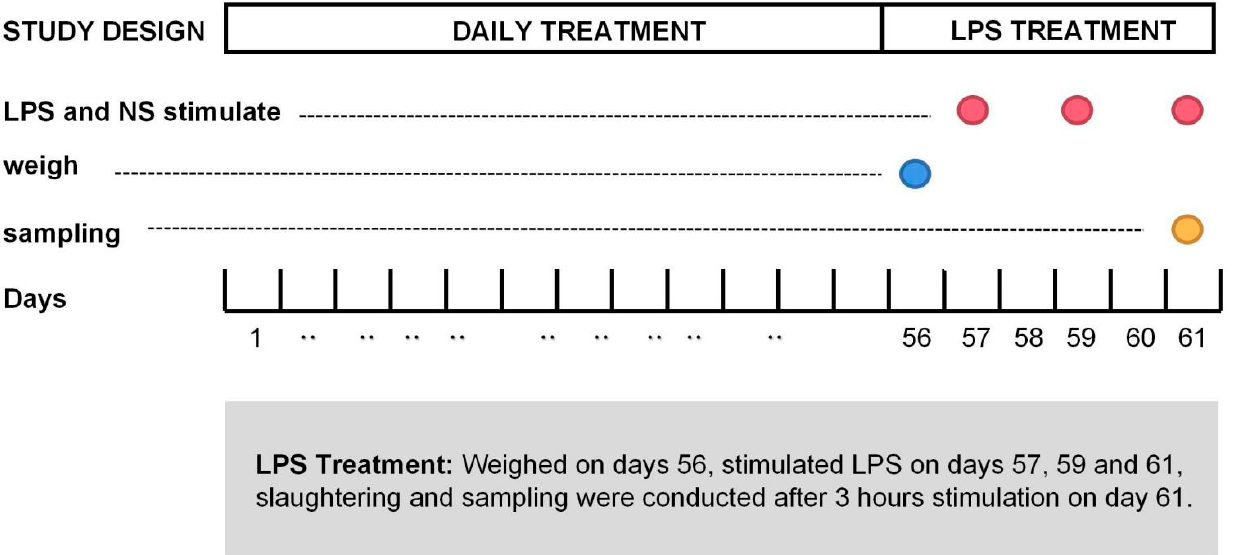
Figure 6. Design of LPS treatment. The blue circle represents the date of weighting, red circles represent the date of stimulated by rhamnolipids (LPS) or normal saline (NS) and the yellow circle represents the date of sampling.